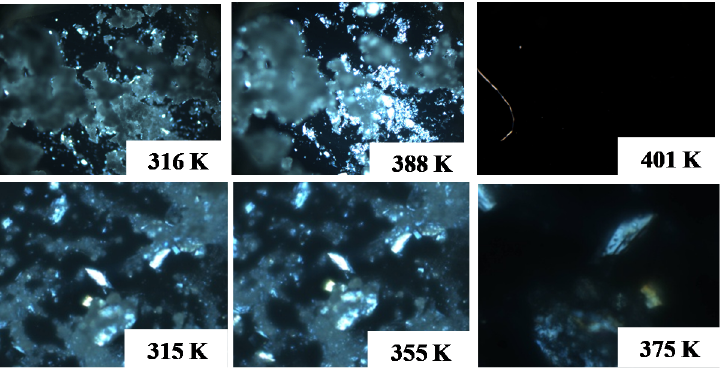
Figure 7. Micrographs at different temperature for cholesterol + phytosterol ( 1st row ) and cholesterol + γ -oryzanol ( 2nd row ) after digestion.